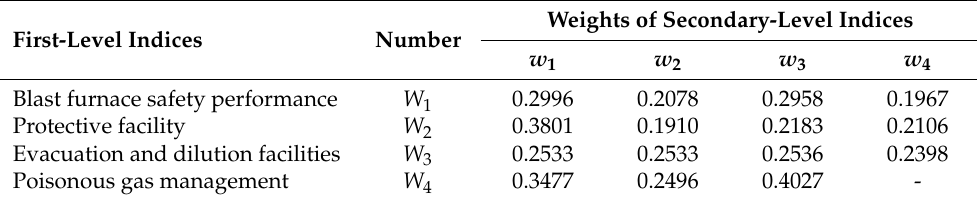
Table 4. Weight vectors of first-level indices.